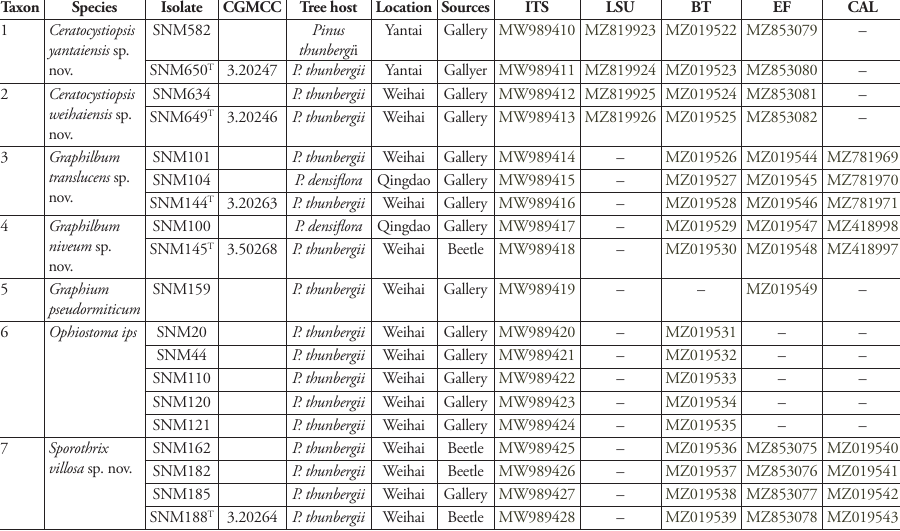
Table 1. Isolates of ophiostomatoid fungi isolated from Cryphalus piceae in this